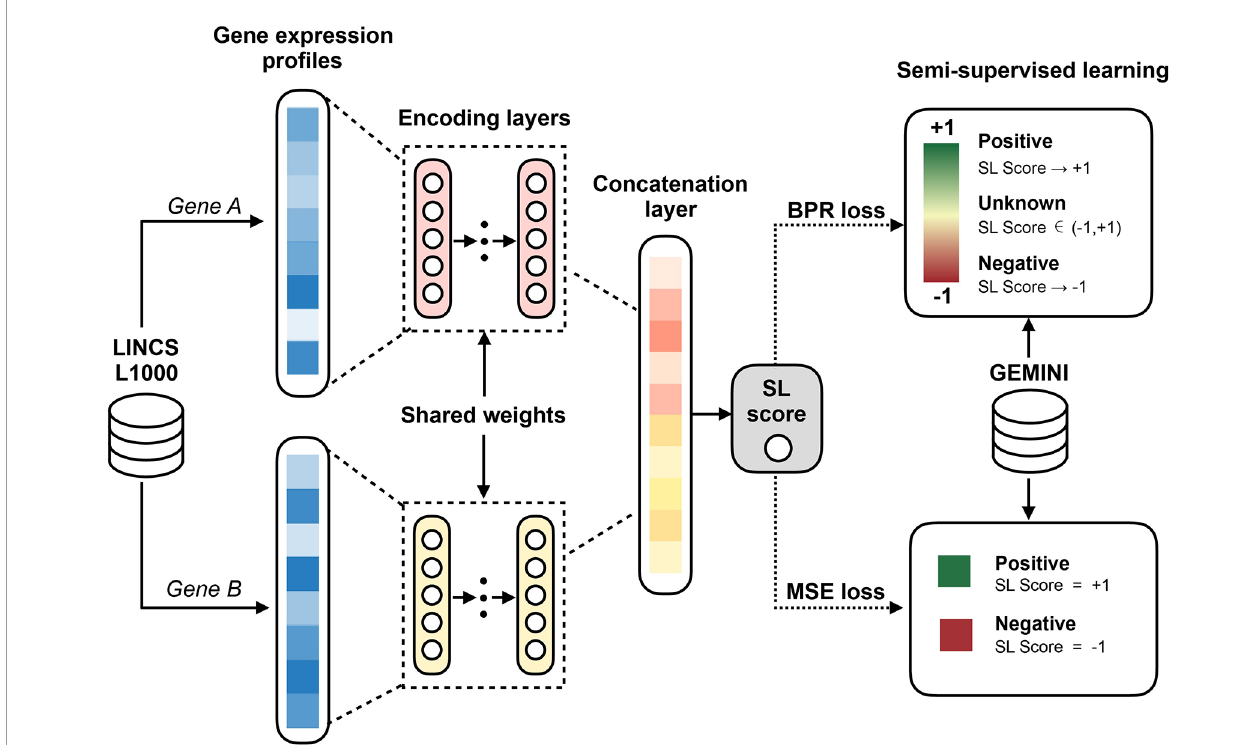
FIGURE 1 | Work fl ow of the EXP2SL model. For a pair of gene, their L1000 gene expression pro fi les derived from knockdown conditions are the inputs of the encoding layers. Then, the updated features for both genes in a given pair are concatenated to predict the con fi dence score of being an SL pair by a linear combination. In addition, a semi-supervised objective function is used to train the model parameters, which aims to utilize the information from both known (positive and negative) and unknown SL gene